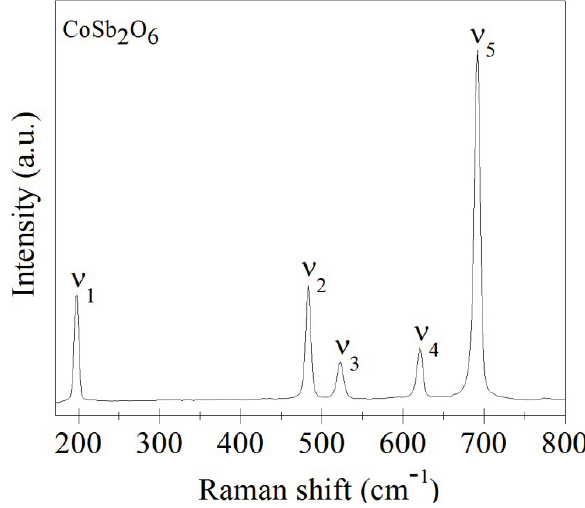
O powders calcined at 600 °C in 2 6